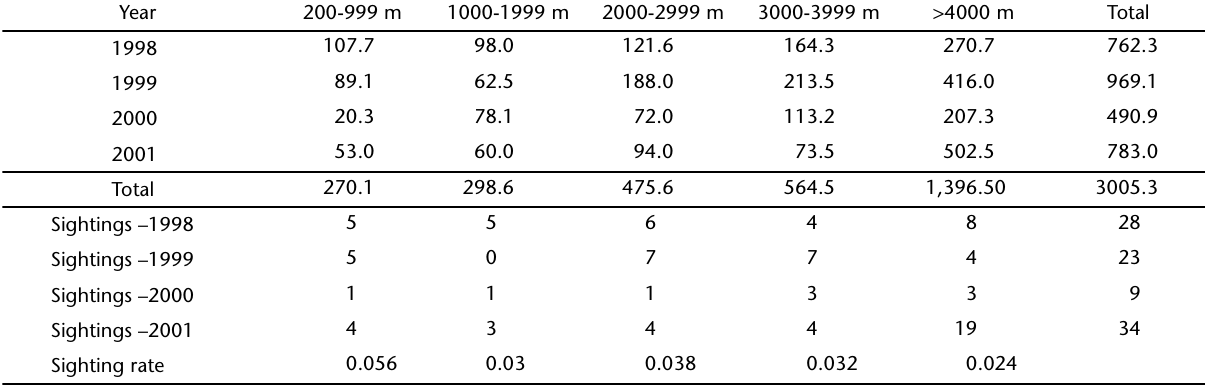
Table III. Searching effort (nm) stratified by depth intervals during the sighting survey conducted off Northeastern Brazil. Sighting rate (number of groups seen/nautical mile) of minke whales at different depths during the surveys conducted in 1998, 1999, 2000 and 2001 off the Northeastern